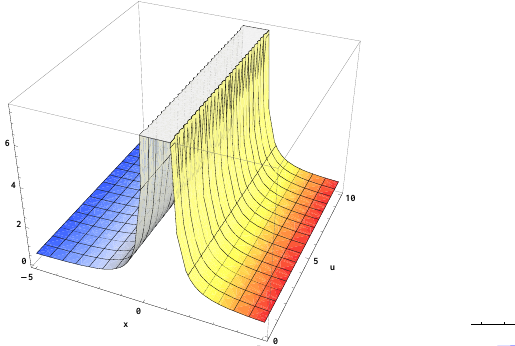
Figure 1. Singular periodic solution (13) ( left ) and its projections at t = 0 ( right ), when a = 0.6, c = 0.3, δ = 1, k = 0.7, A 1 = 0.5, A 2 = 0.1, and y = 0.5.